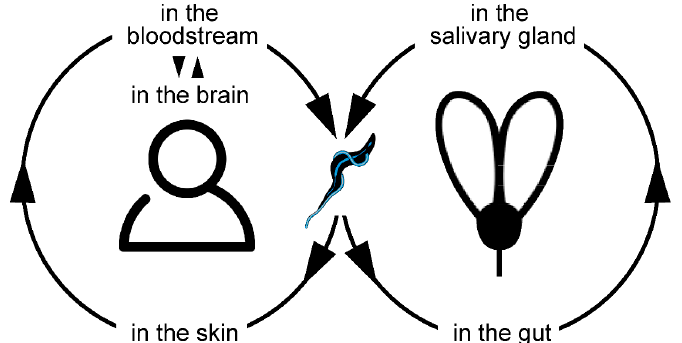
Figure 2. Trypanosome life cycle. The trypanosomes shuttle between the mammalian host and the insect vector. In human infections, the parasites travel from the skin to the circulation and later on, colonise the brain fluids. After uptake with the blood meal of a tsetse fly, the trypanosomes undergo a complex developmental cycle within the insect, before they are re-injected into the host.